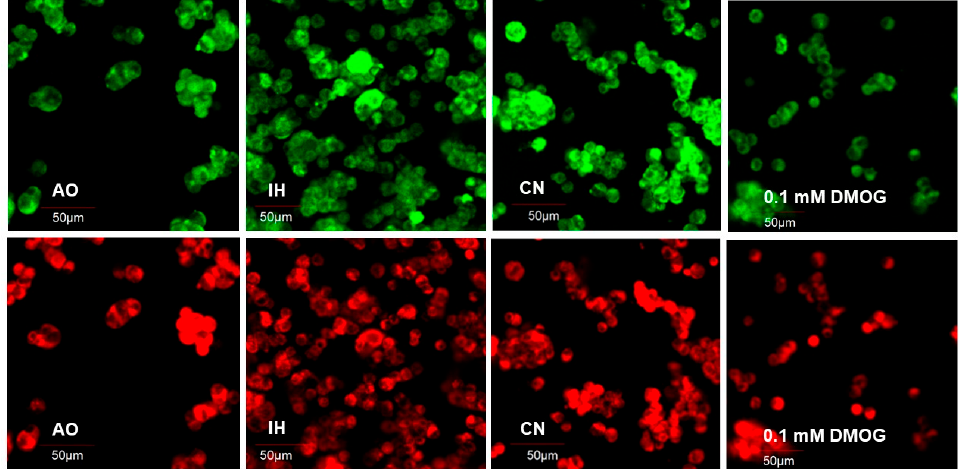
Figure 5. Representative images of PC12 cells loaded with MitoTracker Green and Red fluorescence at different oxygen levels and with DMOG. PC12 cells were cultured in collagen IV precoated 24-well plates in air oxygen (AO), intermittent hypoxia (IH) or continuous normoxia (CN) or with DMOG 0.1 mM in AO for a 96 h time-course. The top panels are MitoTracker Green fluorescence images; the bottom panels are MitoTracker Red fluorescence images. Scale bar indicates 50 µ